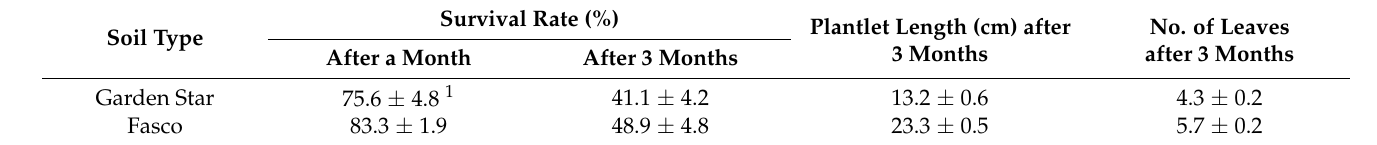
Figure 7. Effect of acclimatization of in-vitro-propagated black cardamom plantlets after transfer in the greenhouse conditions: ( a ) in-vitro-propagated plantlets; plantlets after 1 ( b ) and 3 ( d ) months of planting on “Fasco” bio-soil; plantlets after 1 ( c ) and 3 ( e ) months of planting on “Garden Star” soil. Scale bar = 2 cm. Table 4. Effect of different soil types on efficiency of black cardamom plantlet adaptation and their morphometric characteristics.